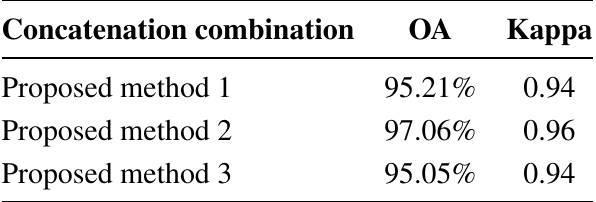
Table 6. Classification accuracies of concatenation combination algorithms.